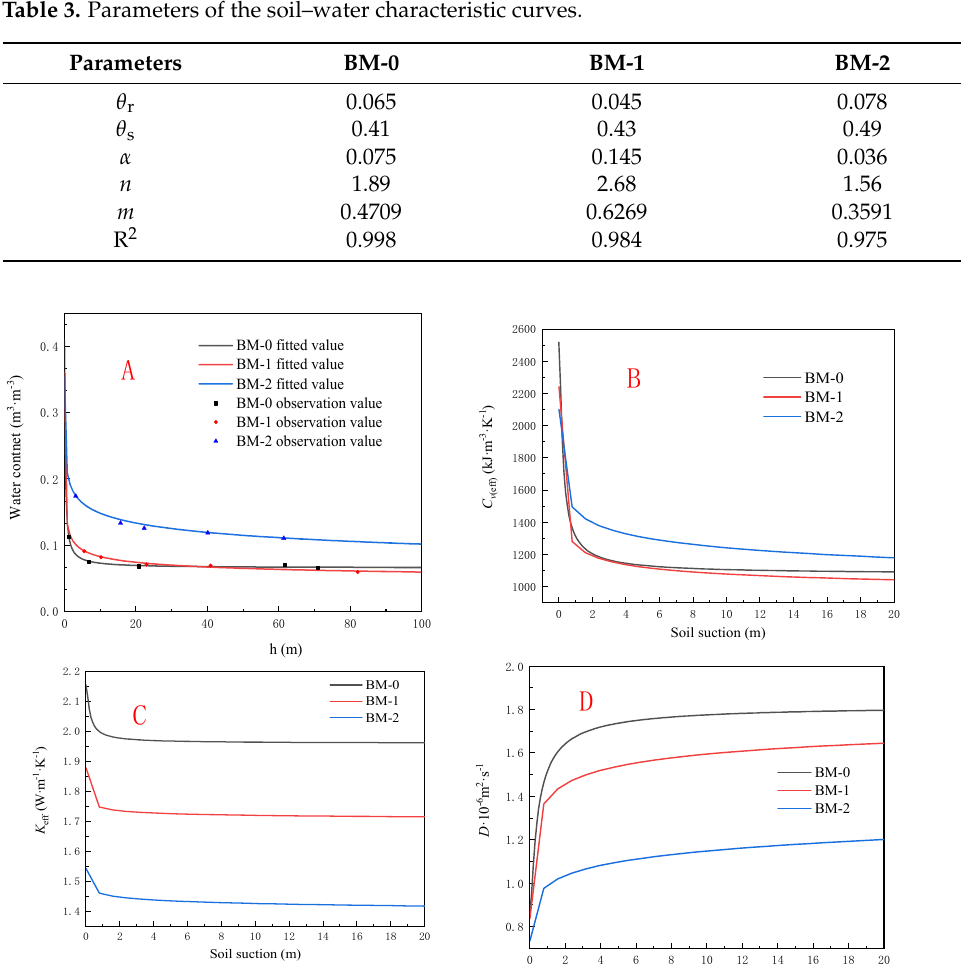
Figure 3. SWCCs and relative thermal properties. ( A ) Soil water characteristic curve; ( B ) Specific heat capacity; ( C ) Thermal conductivity; ( D ) Thermal diffusivity. ( A ) was obtained by data fitting; ( B – D ) were